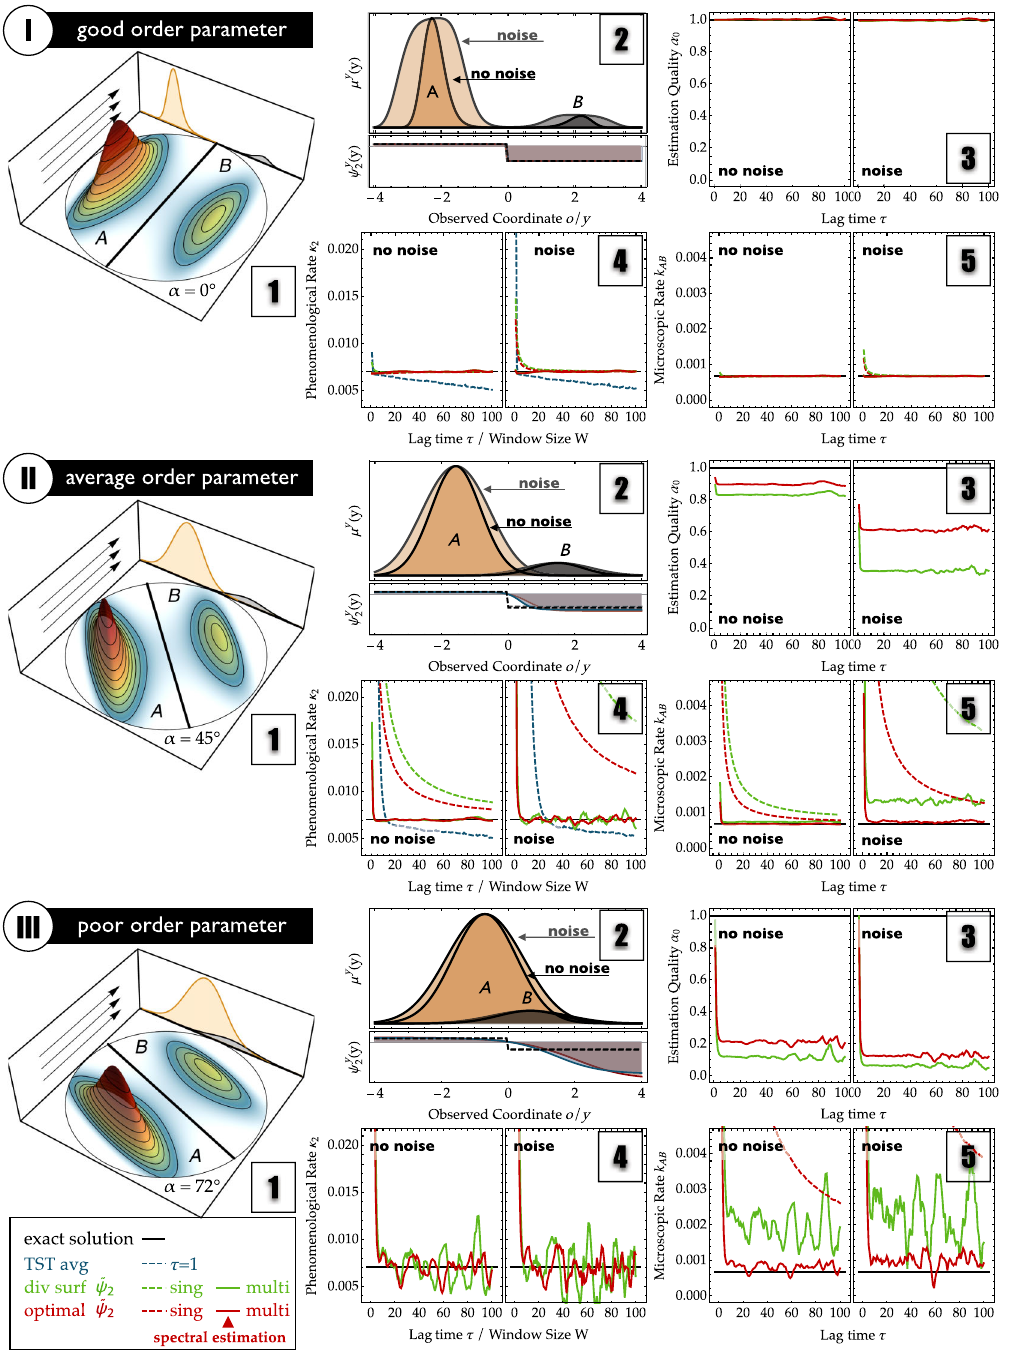
FIG. 2. Estimation results using overdamped Langevin dynamics in a two-dimensional two-well potential that is projected onto different observables: (I) perfect projection, (II) average-quality projection, (III) poor projection. Results are compared without noise (left half of panels) and with additional measurement noise (right half of panels). (1) Full state space with indicated direction of the used order parameter. (2) Top: Stationary density μ y ð y Þ in the observable of the two partial densities of states A (orange) and B (gray). Results with noise are shaded lighter and are more spread out. Bottom: Second eigenvector without noise (solid, blue), with noise (solid, red), and dividing surface (black, dashed line). (3) Estimation quality α from spectral estimation (OQ, red line), and from exponential fitting to the number correlation function using a diving surface at y ¼ 0 (green line). (4) Estimated relaxation rate κ 2 : TST with averaging window of size W (indicated in the x axis). Dividing surface at o ¼ 0 with single- τ (dashed green line) and multi- τ (solid green line) estimators. Estimates from a MSM-derived second eigenvector ~ ψ 2 with a single- τ estimate (normal MSM, dashed red line) and multi- τ estimate (spectral estimation, solid red line). The black line is the reference solution, obtained from a direct MSM estimate for τ ¼ 50 in row 1. (5) The transition rates k AB from state A to B . The coloring is identical to panels